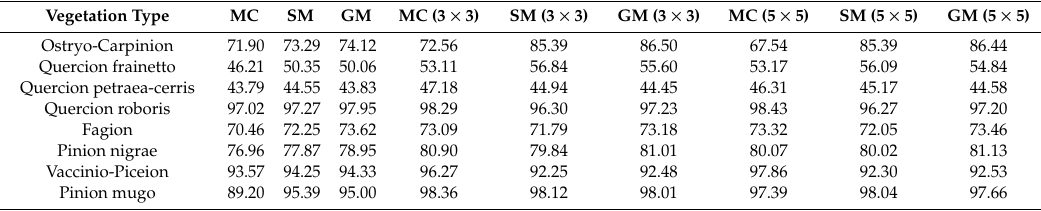
Table A4. User’s accuracy for all woody vegetation classes for 5-fold LLOCV.